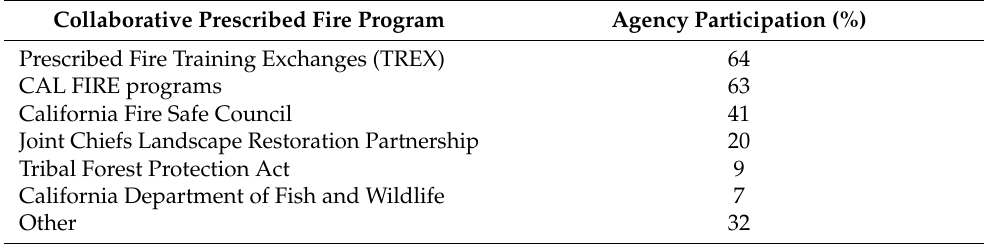
Table 2. Agency or Organization Participation in Collaborative Prescribed Fire Programs. Surveyed managers were asked if their agency or organization participated in these collaborative